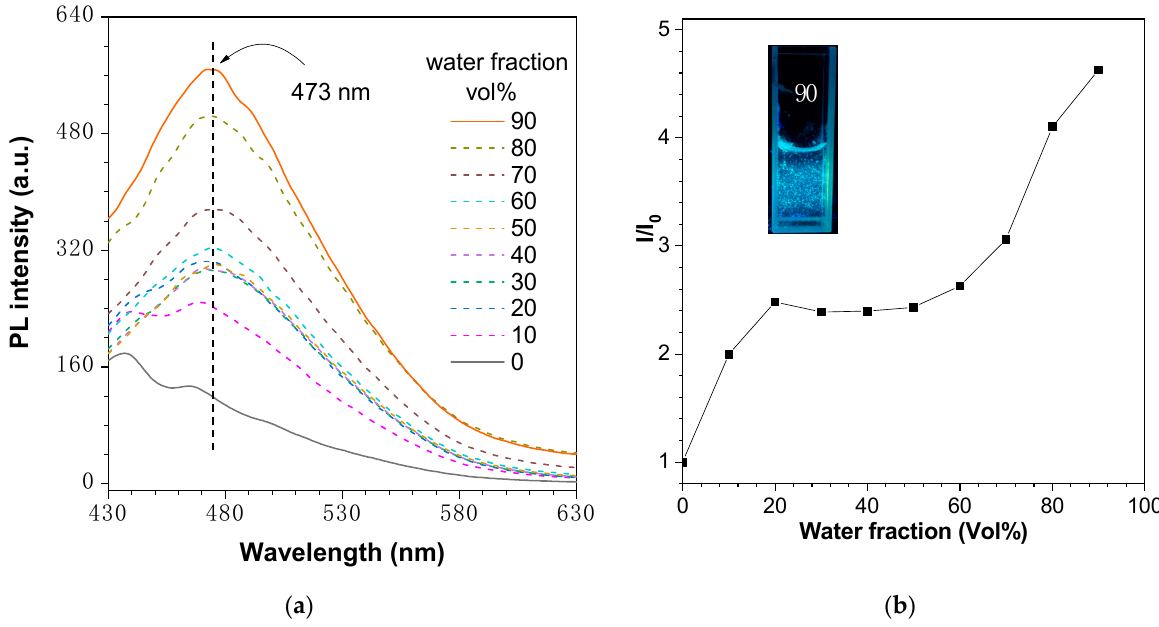
Figure 6. ( a ) PL behavior of P 6 in THF/water mixtures with different water fractions ( f w ). ( b ) Plot of peak intensity of P 6 in THF/water mixtures with different water fractions. I 0 = Peak intensity of P 6 when f w = 0. I = Peak intensity of P 6 when f w = 0. λ ex = 375 nm, Concentration = 100 µ M. Inset: Photographs of the fluorescence of P 6 in THF/water mixtures with a 90% water fraction. On the other hand, PTMSDPA shows a typical ACQ behavior (Figure S9). The flu- orescence intensity decreased with the increase of water fraction, which is similar to the luminescence behavior of most diphenyl acetylene derivatives [21–25]. According to